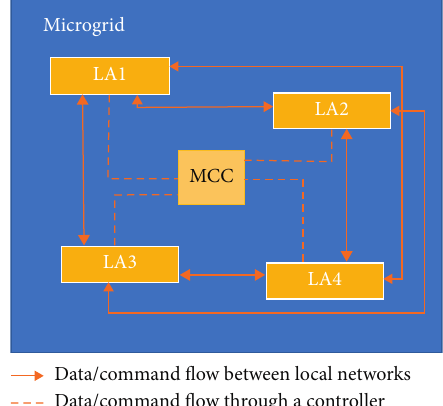
Figure 5: Distributed control with agents. This diagram illustrates the data and command flow between the local areas through agents as well as how the commands are centralized using a microgrid controller.